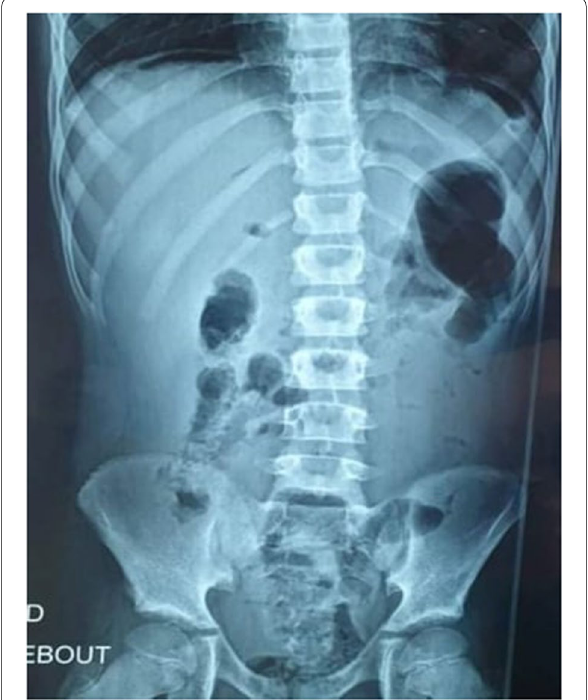
Fig. 1 Plain abdominal X-ray revealing free air under both copulae of the diaphragm